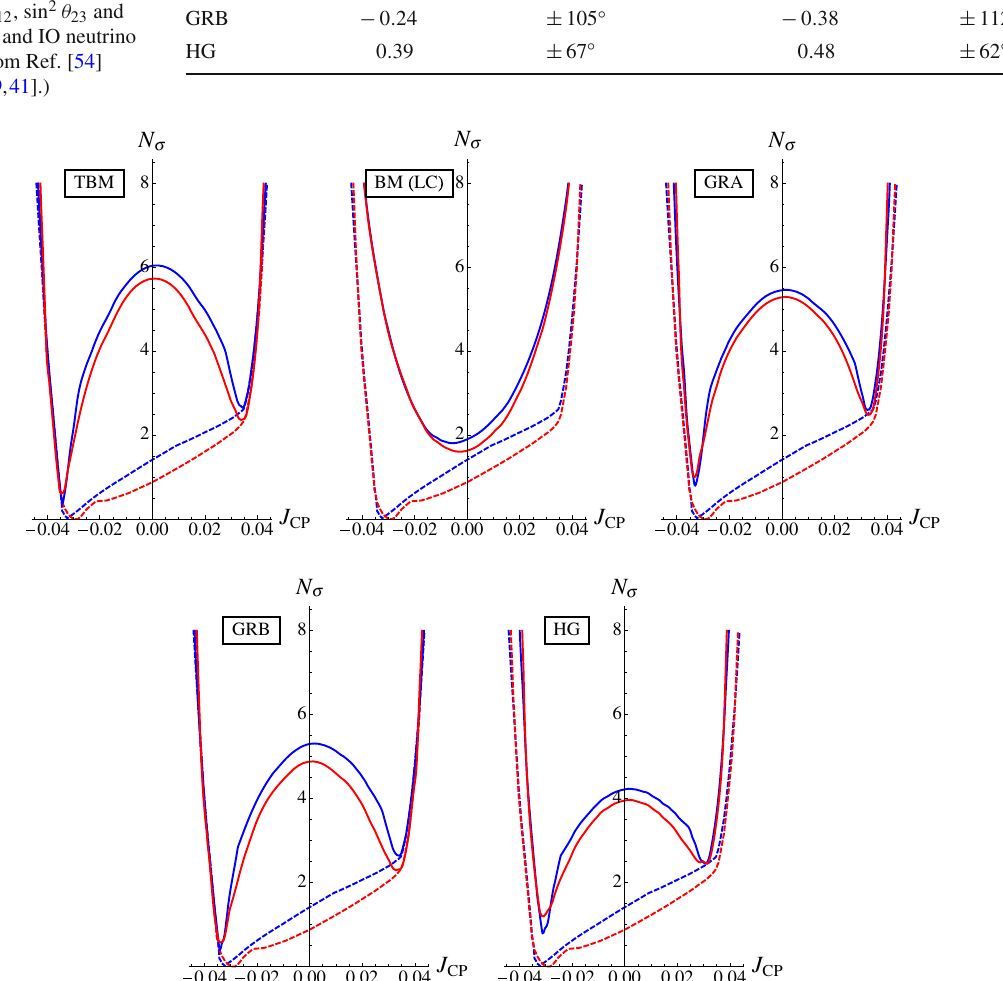
(cid:19) χ 2 as a function of J Fig. 1 N σ ≡ GRB and HG (lower left and right panels) neutrino mixing symmetry CP . The dashed lines represent the resultsoftheglobalfit[56],whilethesolidlinesrepresenttheresultswe forms. The blue (red) lines are for NO (IO) neutrino mass spectrum. obtain for the TBM, BM (LC), GRA (upper left, central, right panels), (From Ref.